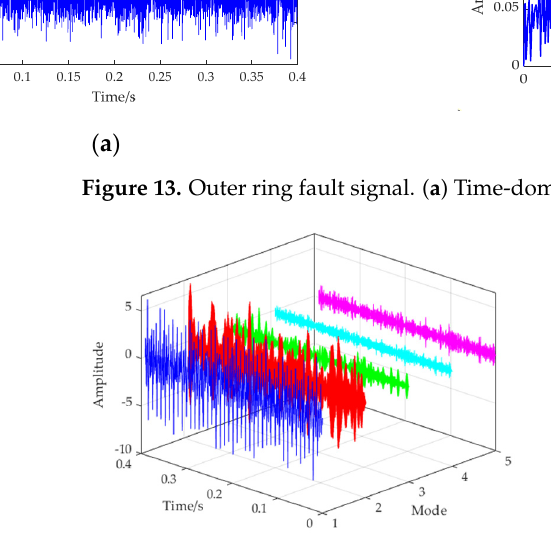
Figure 14. Decomposition results of outer fault signals using CLNGO-FMD.